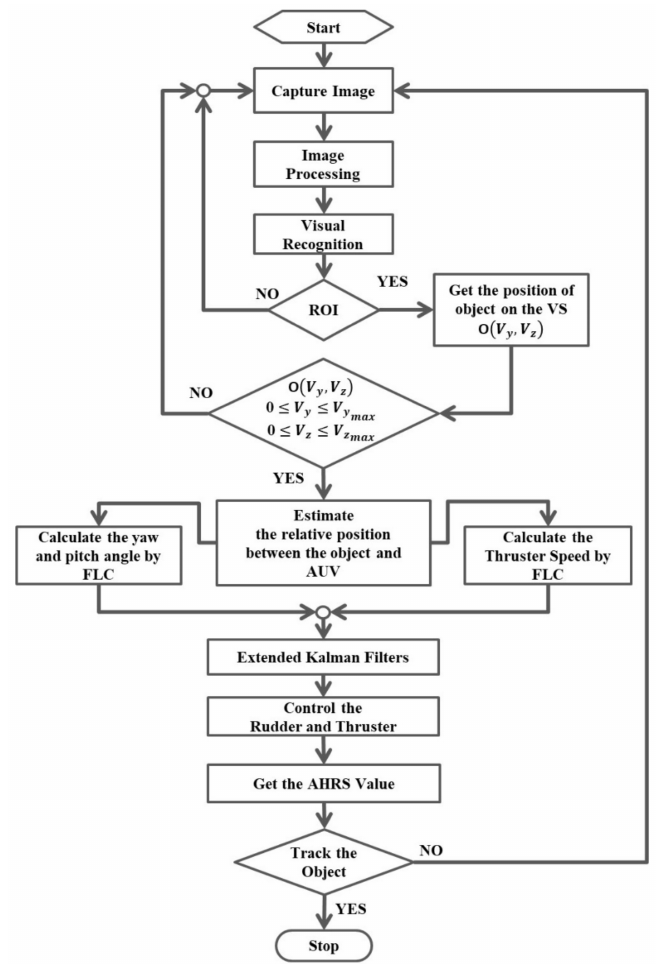
Figure 15. The flow chart of the image-based navigation system in the